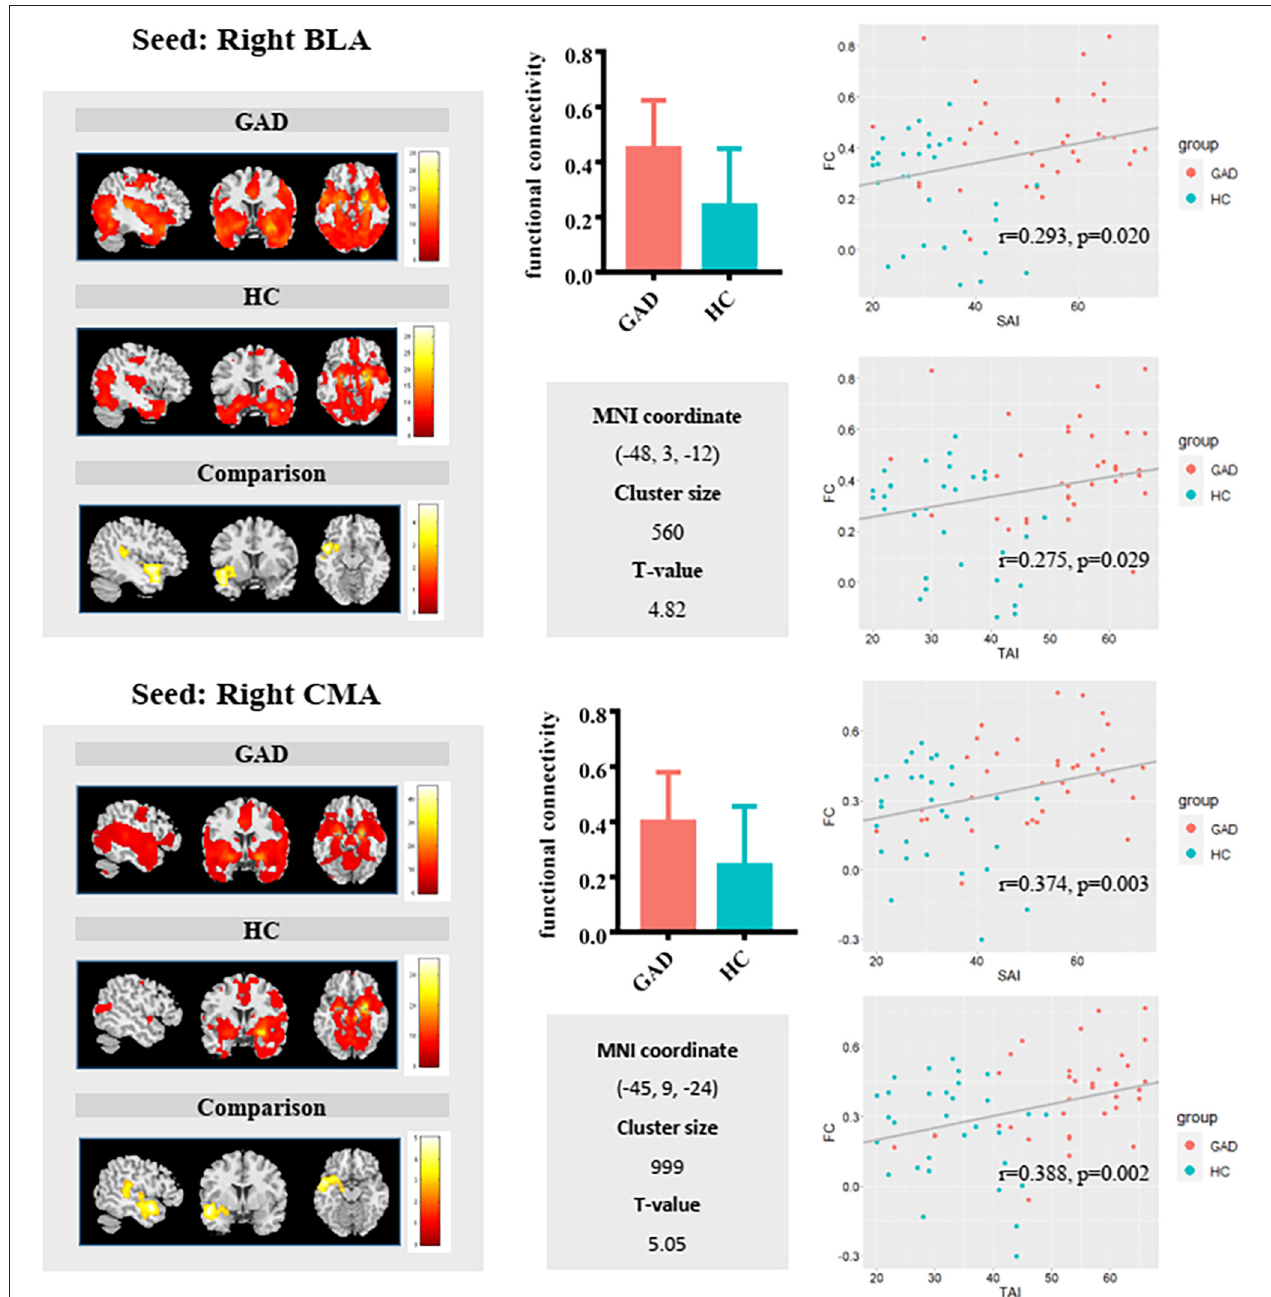
FIGURE 2 | Group comparisons in FC of the right basolateral amygdala (BLA) (upper panel) and right centromedial amygdala (CMA) (lower panel) revealed relatively similar results. GAD patients exhibited significantly increased right BLA/CMA functional connectivity with a cluster including the superior temporal gyrus and insula. Additionally, the scatterplot showed positive associations between FC and State Anxiety Inventory (SAI)/Trait Anxiety Inventory (TAI) in the sample as a